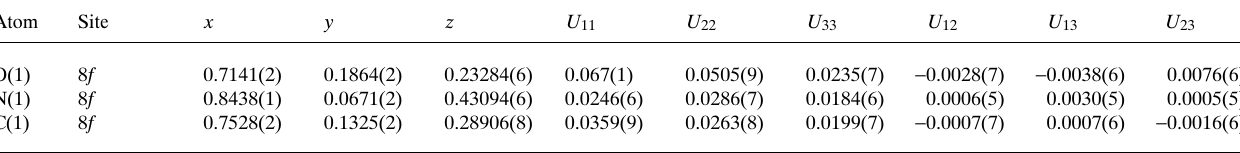
Table 3. Atomic coordinates and displacement parameters (in Å 2 ) .